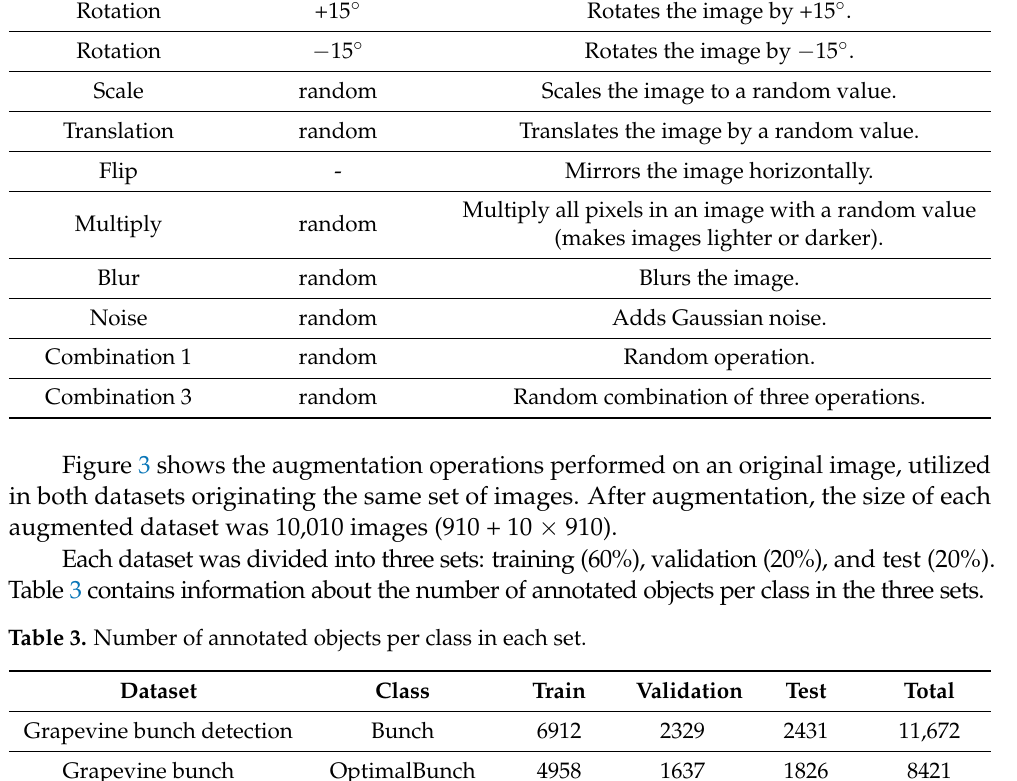
Table 2. Description of the augmentation operations used to increase the original dataset. Operation